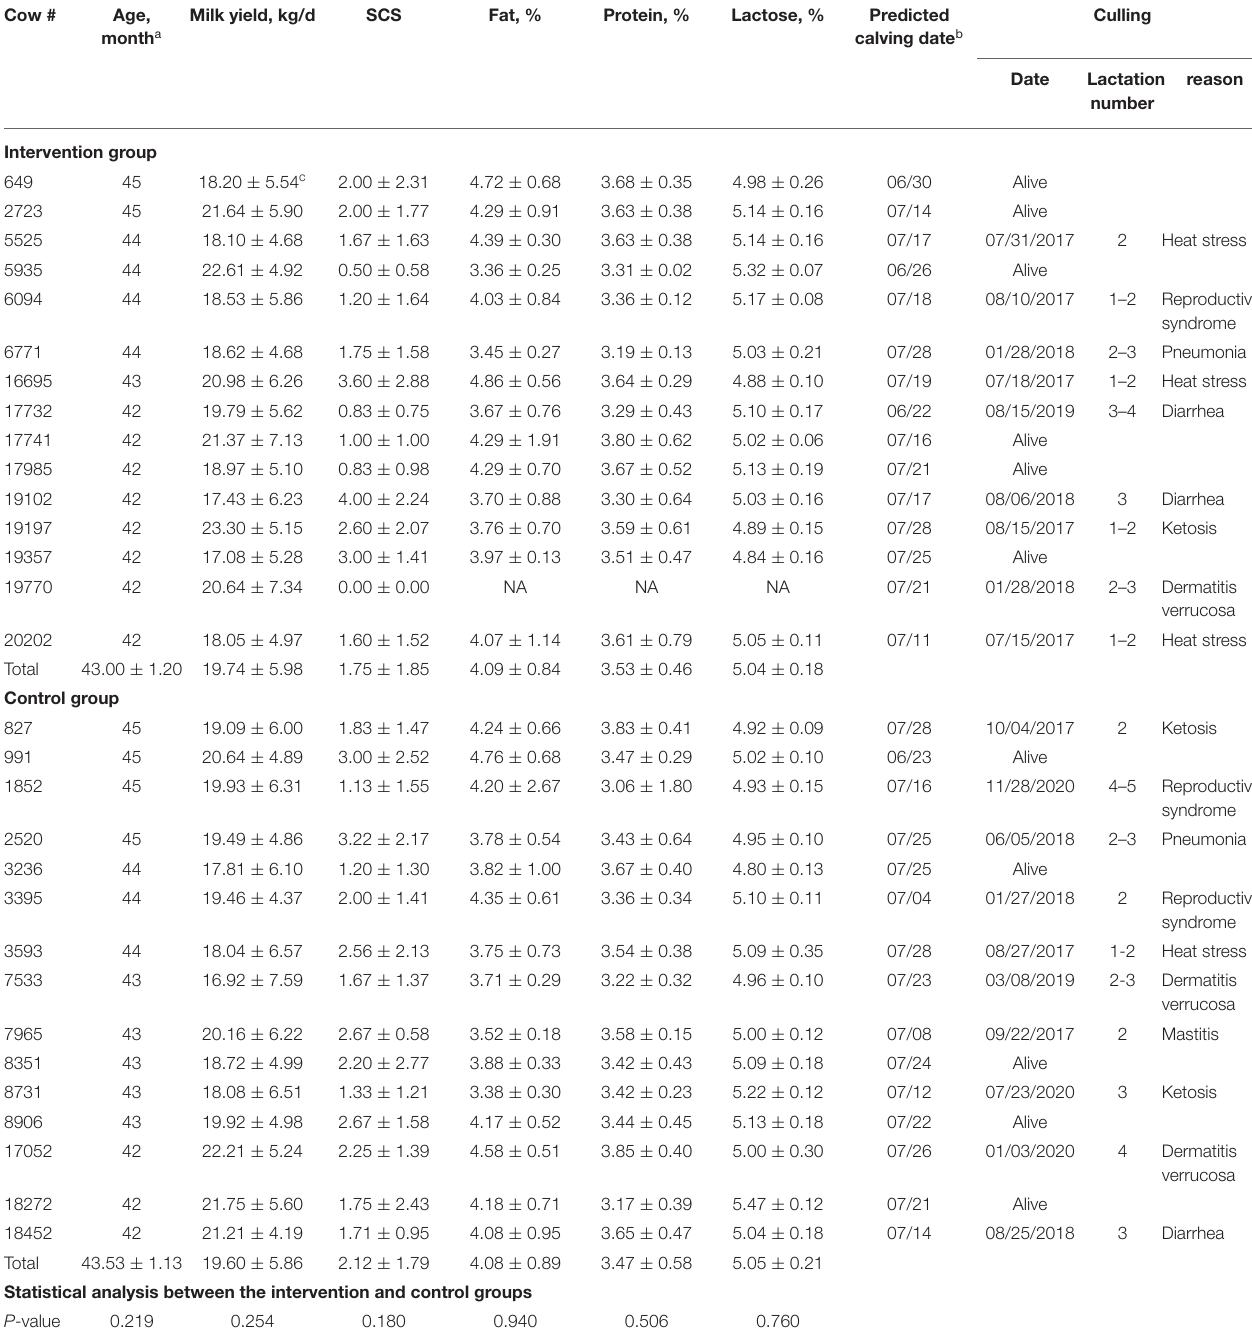
TABLE 1 | Comparison of age, average daily milk yield, SCS, milk composition, predicted calving dates, and culling events of cows in the intervention and control groups before BLV inoculation. Cow # Age, Milk yield, month a